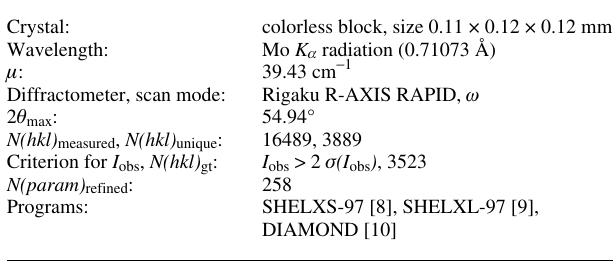
Table 2. Atomic coordinates and displacement parameters (in Å 2 ) . Table 1. Data collection and